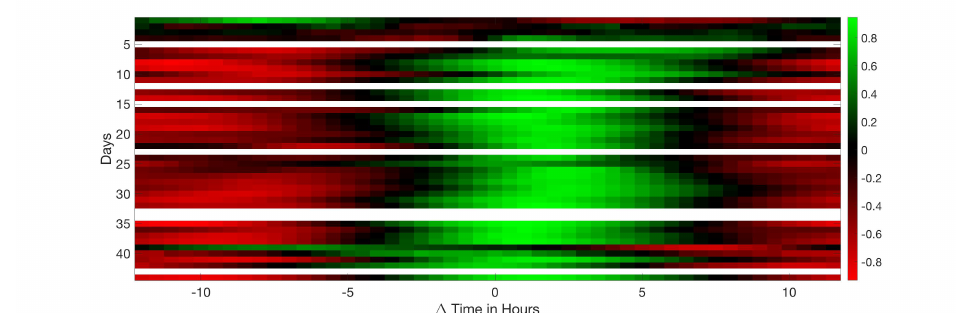
Figure 15. Results of the circular correlation CO 2 —humidity. Horizontal axis corresponds to the ∆ Time measured in hours, evaluating the delay between CO 2 and humidity. Vertical axis stands for the days of the cycle.